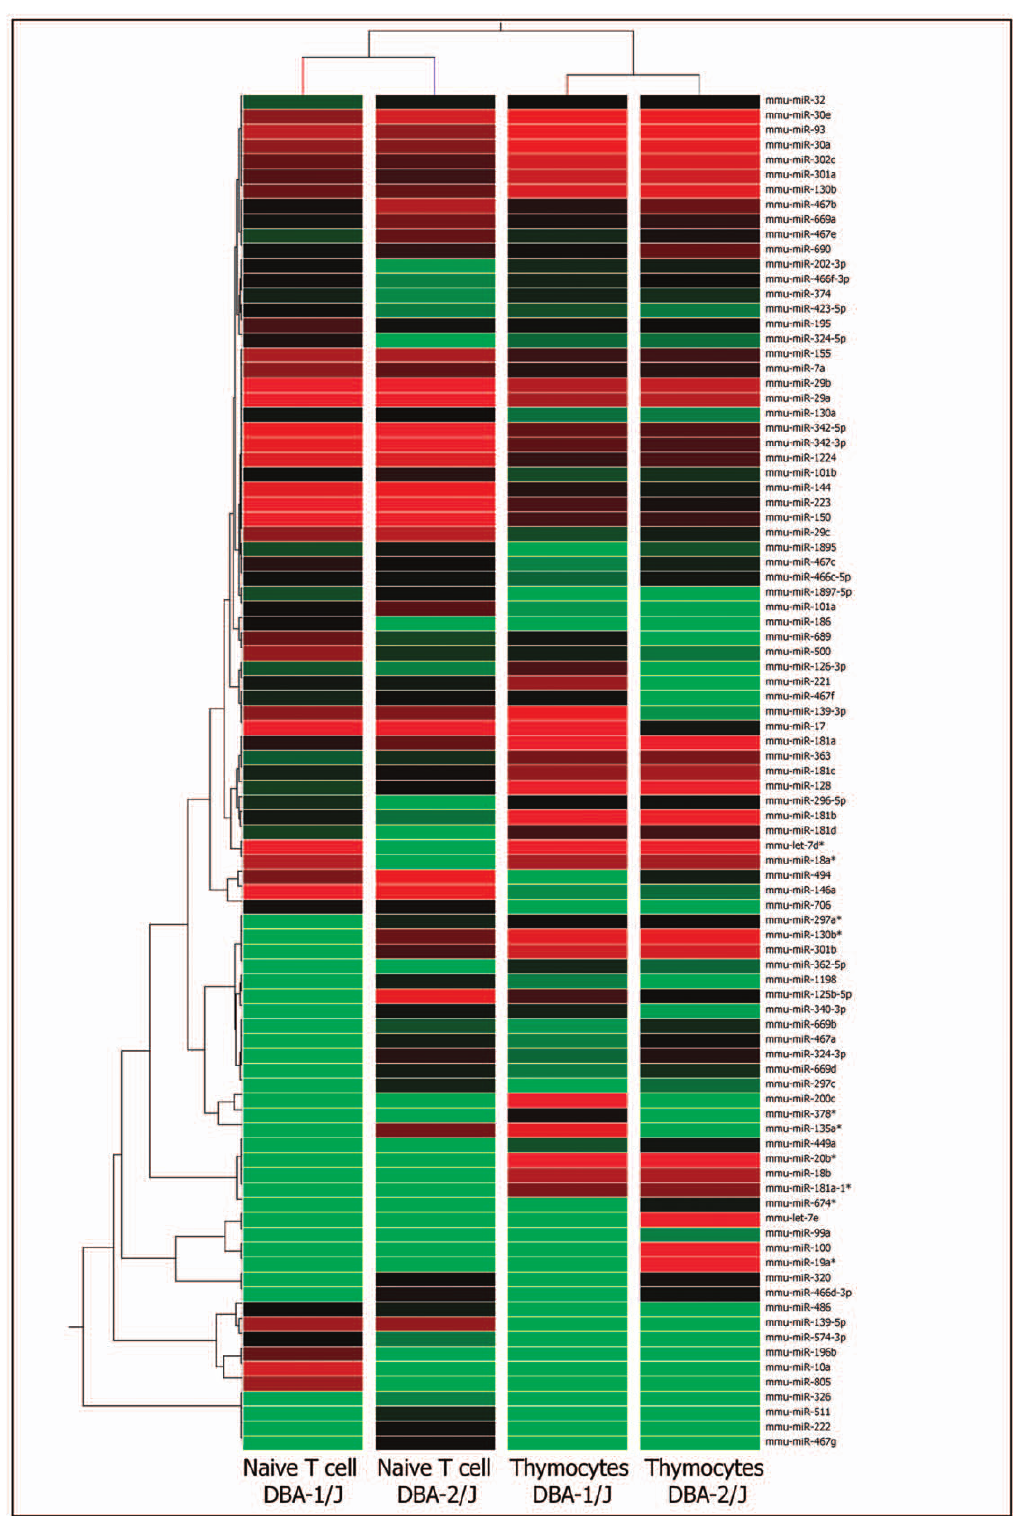
Figure 1. Modulation of miRNAs as evaluated by microarrays. Hierarchical clustering and color heat-map of miRNome (miRNAs) of thymocytes isolated from 4-week-old DBA-1/J and DBA-2/J mice and CD3 + T cells from the spleen and lymph nodes of 4-week-old mice from both strains based on microarray expression profiling. The dendrogram and heat-map were obtained using cluster and tree-view algorithms through Agilent GeneSpring platform. Heat map legend: Red=up regulation, green=down regulation, black=unmodulated (Pearson correlation metrics).